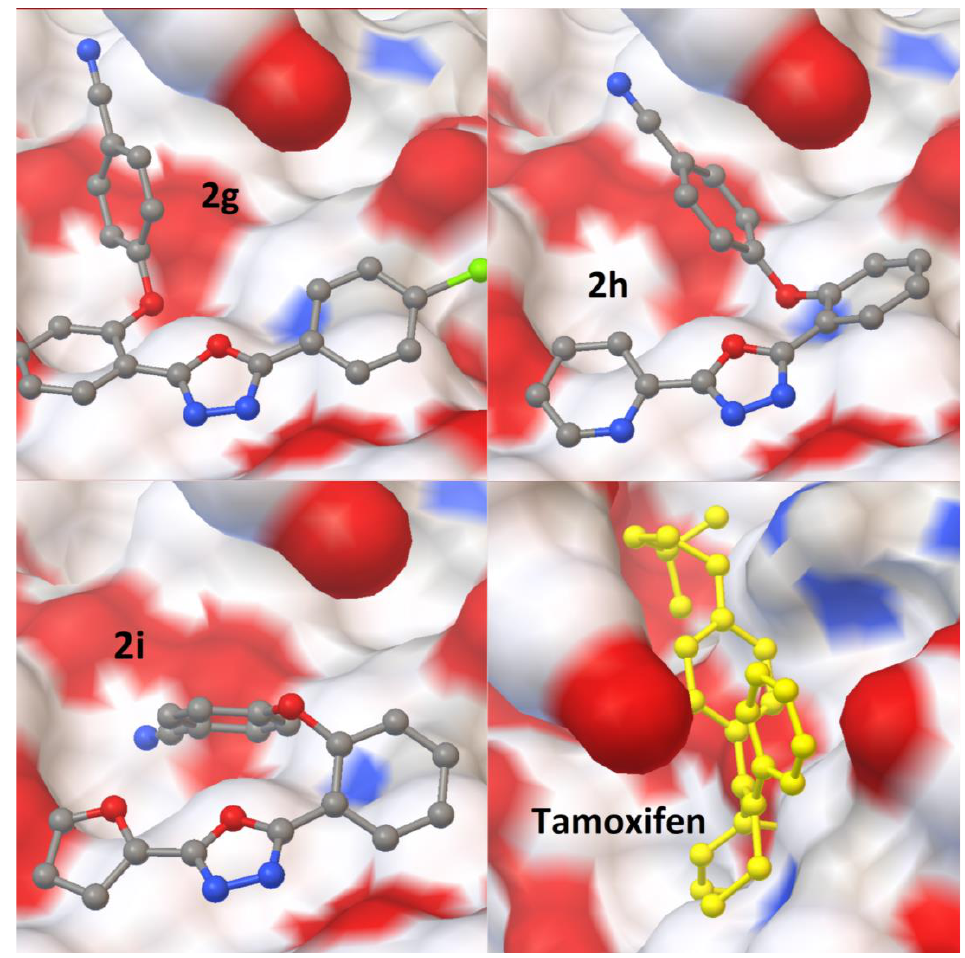
Figure 10. Interaction of the best-docked poses of compounds 4g , 4h , 4i and reference drug tamoxifen to 3KRR target.